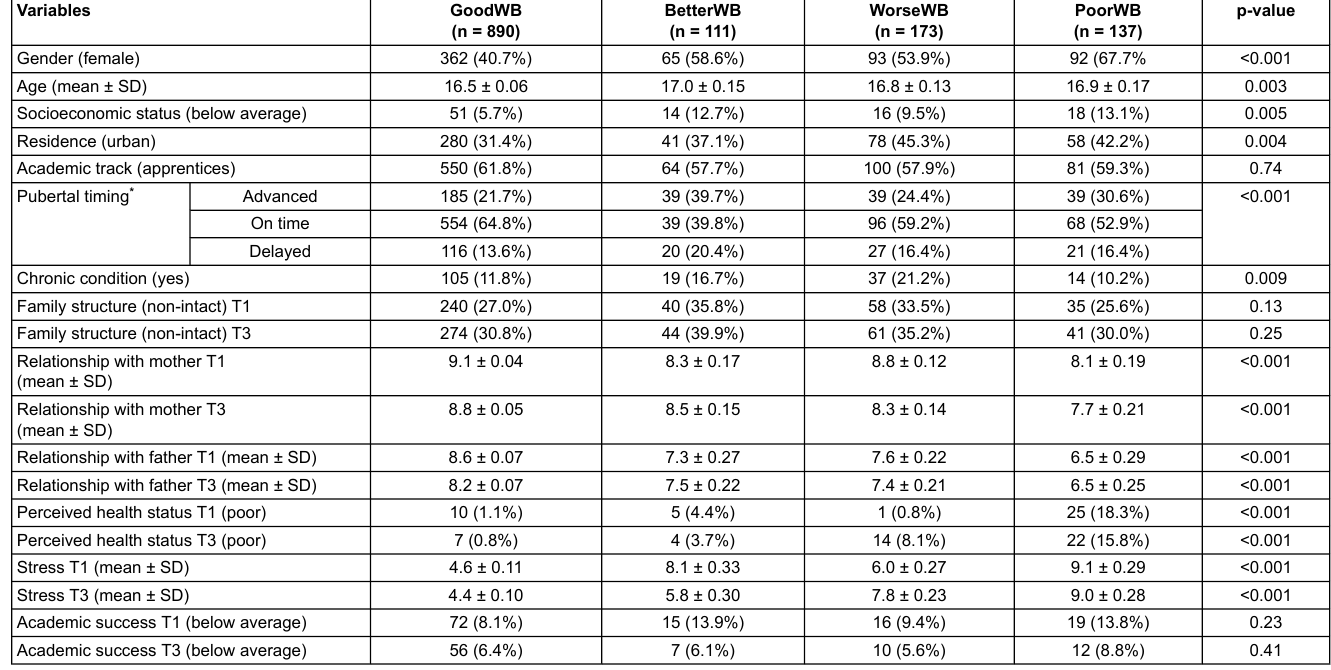
Table 1: Bivariate analysis comparing the four study groups.